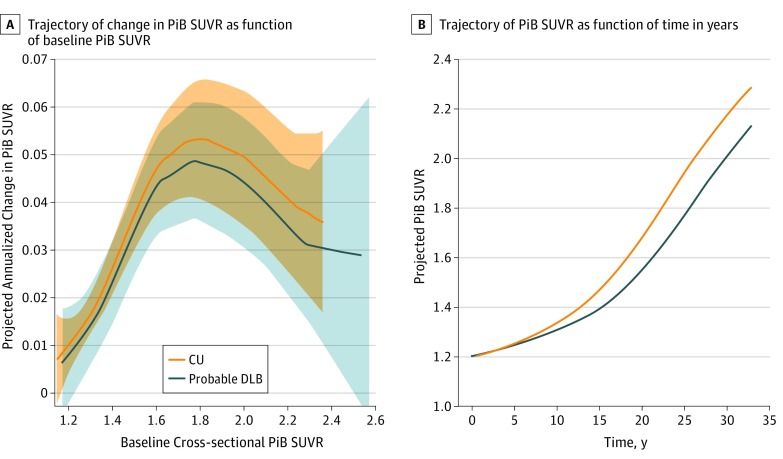
Trajectories of Change in Carbon-11 Labeled Pittsburgh Compound B Standardized Uptake Value Ratio (PiB SUVR) and Baseline PiB SUVRA, Regardless of clinical group, change in PiB SUVR increases, peaks at a baseline PiB SUVR of approximately 1.8, and then decreases, forming an inverted U–shaped curve. Change in PiB SUVR did not differ between the probable dementia with Lewy bodies (DLB) and cognitively unimpaired (CU) groups in the shape or vertical shift between the trajectories; confidence bands, indicated by shaded areas, largely overlap. The widening of the confidence bands on the right side of the panel reflects the lower number of participants (n = 11) with higher baseline PiB SUVR values (ie, >1.7). B, The inverted U–shaped curves were integrated into the sigmoid-shaped trajectory of cumulative PiB SUVR as a function of time in years.